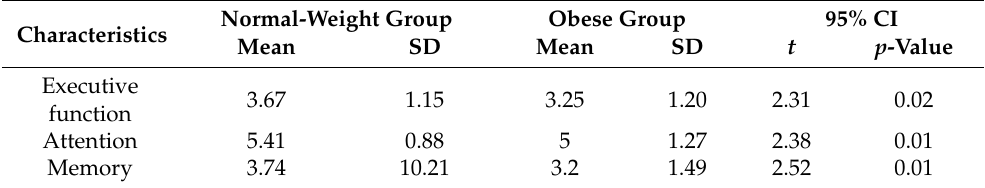
Table 3. Neurocognitive functioning performance by weight